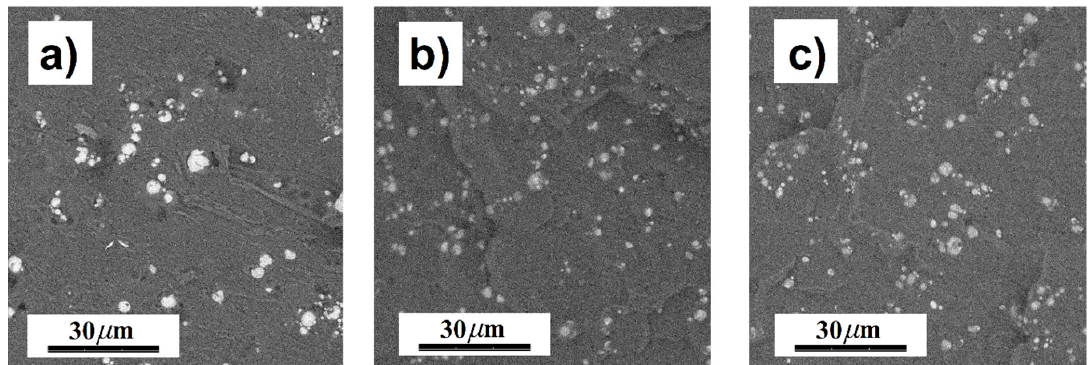
Figure 7. SEM images of the MREs containing ( a ) bare CI, ( b ) CI ‐ g ‐ PHEMATMS ‐ 1, and ( c ) CI ‐ g ‐ PHEMATMS ‐ 2 particles.